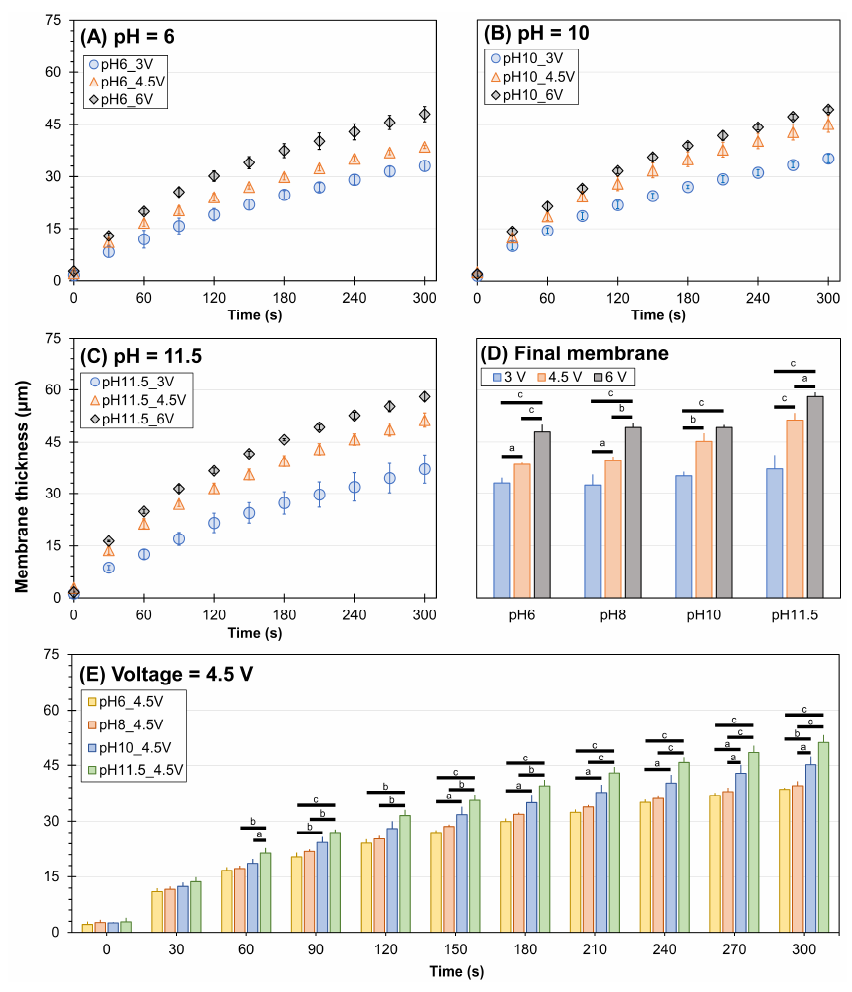
Figure 3. The thickness of chitosan membranes electrofabricated under different conditions. The applied voltage was varied at 3, 4.5, and 6 V while the pH of alginate solution was fixed at ( A ) 6, ( B ) 10, and ( C ) 11.5 (refer to Figure 2 for the case of pH 8). ( D ) Resulting membrane thickness at 5 min at various pH and voltages. ( E ) The applied voltage was fixed at 4.5 V while the pH of the alginate solution was varied at 6, 8, 10, and 11.5. Results of pairwise comparisons are indicated by a ( p < 0.05), b ( p < 0.01), and c ( p < 0.001), with Tukey test comparisons indicated by horizontal bars connecting the compared groups.